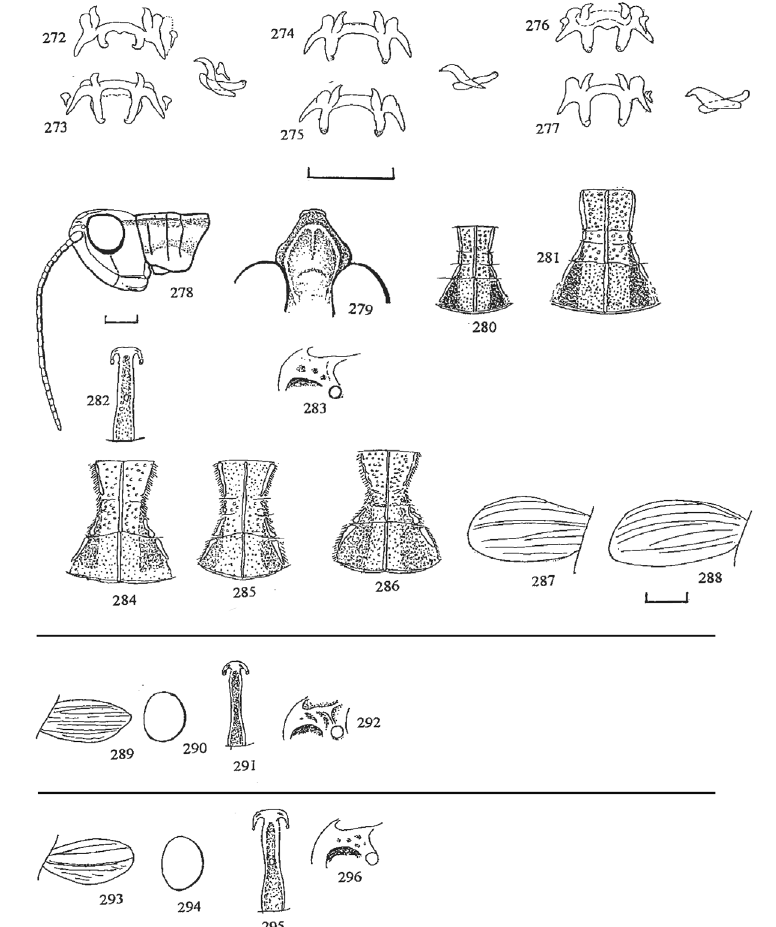
Figs 272–296. Tribe Gymnobothrini. Gymnobothrus pullus. Figs 272–288. Gymnobothrus pullus pullus : 272–277. Variation in epiphal- lus (272, 273, Tanzania, Amani; 274, 275, Tanzania, Mwanza; 276, 277, Malawi); 278. Male, lateral aspect head and pronotum; 279. Dorsal view male vertex; 280, 281. Male, female pronotal discs; 282. Frontal ridge; 283. Temporal foveolus; 284–286. Vari- ation in male pronotal disc; 287, 288. Variation in male tegmen. Figs 289–292 . Gymnobothrus pullus minutus male: 289. Tegmen; 290. Compound eye; 291. Frontal ridge; 292. Temporal foveolus. Figs 293–296. Gymnobothrus pullus hemipterus male: 293. Tegmen; 294. Compound eye; 295. Frontal ridge; 296. Temporal foveolus. All scale lines represent l mm: that below Fig. 275 applies to Figs 272–277, 279, 283, 292, 296; that below Fig. 288 applies to Figs 280–282, 284–288, 291, 293–295, 289, 290; that under Fig. 278 applies to 278